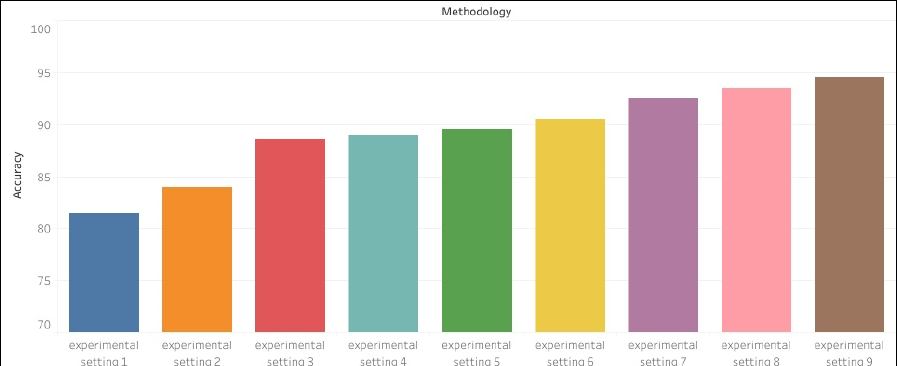
Figure 5. Performance of different proposed experimental settings.